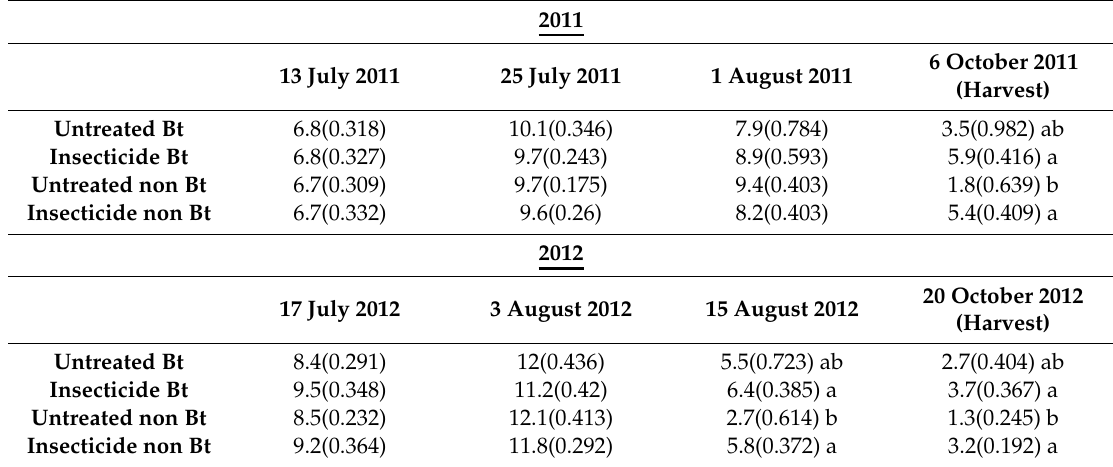
Table 11. Mean (SEM) total 1st position fruit per plant across untreated and insecticide-treated Bt and non-Bt cotton plots in 2011 and 2012 studies. Treatment means within an observation date that are followed by common letters do not di ff er significantly ( p = 0.05, Tukey’s HSD Test). Treatment means within an observation date with no letters are not